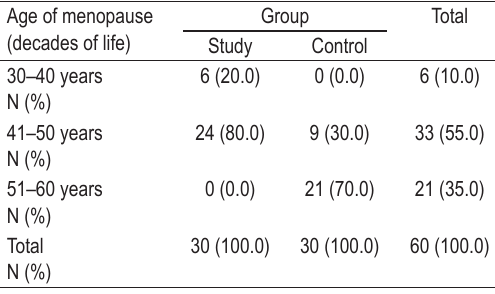
FIGURE 3. The average period between menarche and TABLE 3. Comparison of age of menopause expressed in decades of life by groups